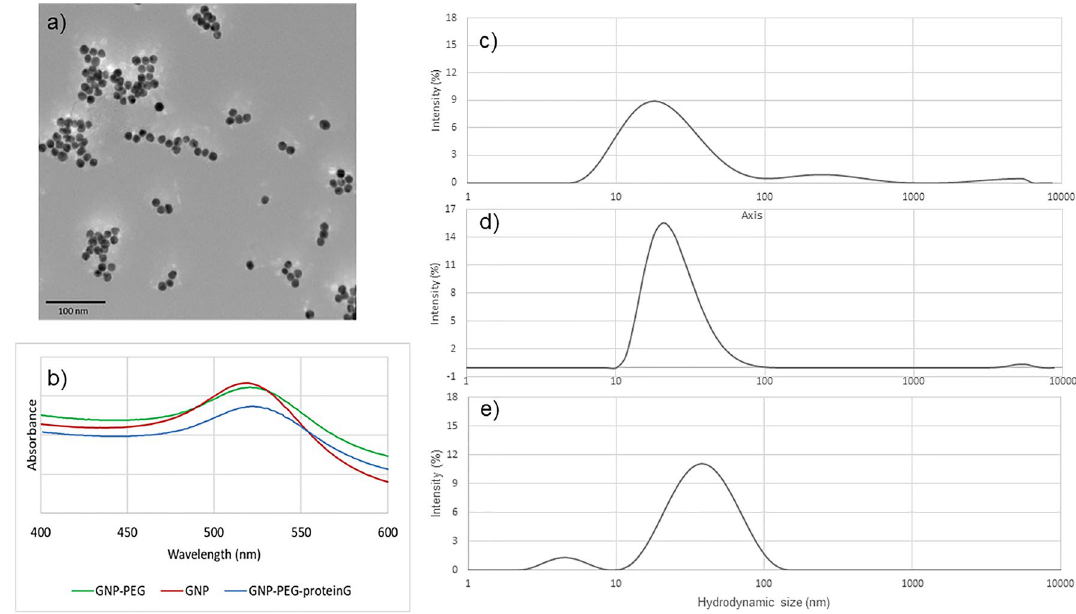
Figure 1. Characterization of the gold nanoparticles (GNP), gold nanoparticles functionalized with polyethylene glycol (GNP-PEG) and affinity labelled with protein G (GNP-PEG-proteinG) ( a ) TEM image of GNPs. ( b ) UV–Vis spectrum of GNP, GNP-PEG and GNP-PEG-proteinG conjugate with λ max = 518, 520 and 521 nm respectively. ( c ) DLS showed the GNP were 18 nm with a zeta potential value − 41 mV. ( d ) DLS showed the GNP-PEG were 35 nm with a zeta potential value − 6.8 mV. ( e ) DLS showed the GNP-PEG-proteinG showed size 37 nm with a zeta potential value − 24.75